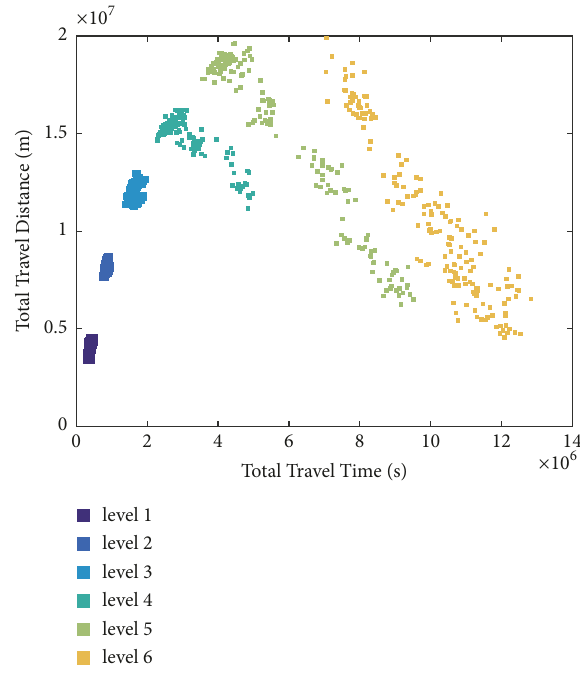
Figure 3: Final network states of 50 min simulations, colored by demand